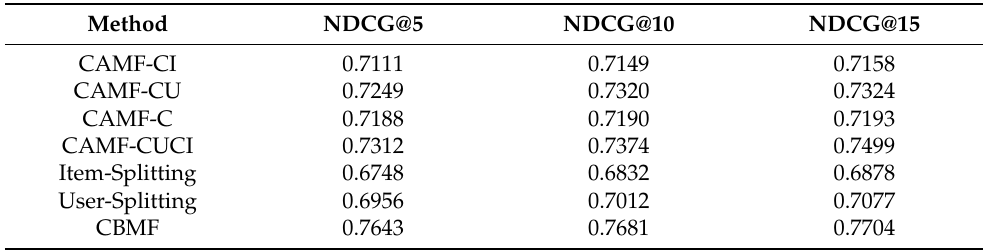
Table 14. Results on DePaulMovie dataset related to Normalized Discounted Cumulative Gain metric and the values N =